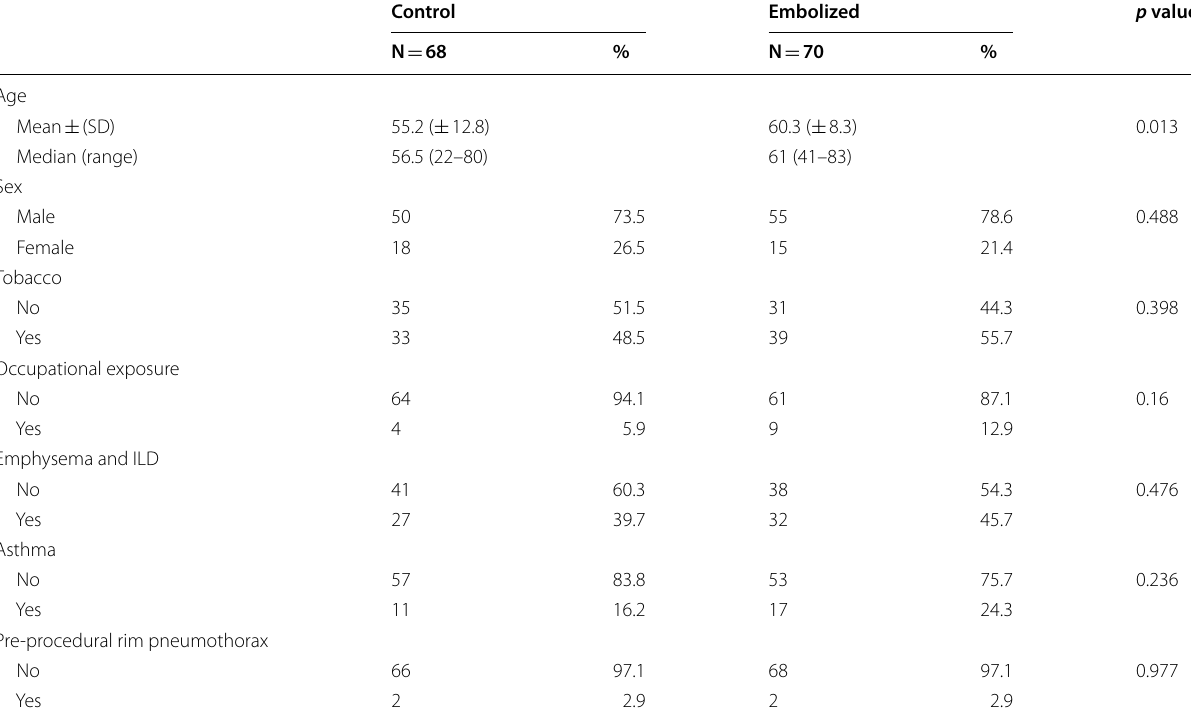
Table 1 Patient characteristics